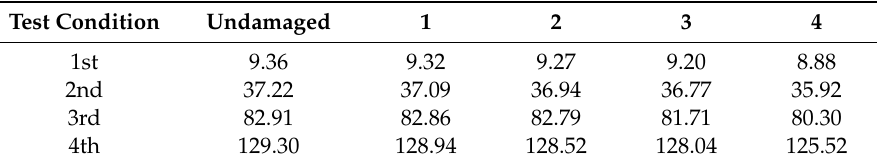
Table 4. Structural frequency under di ff erent conditions.